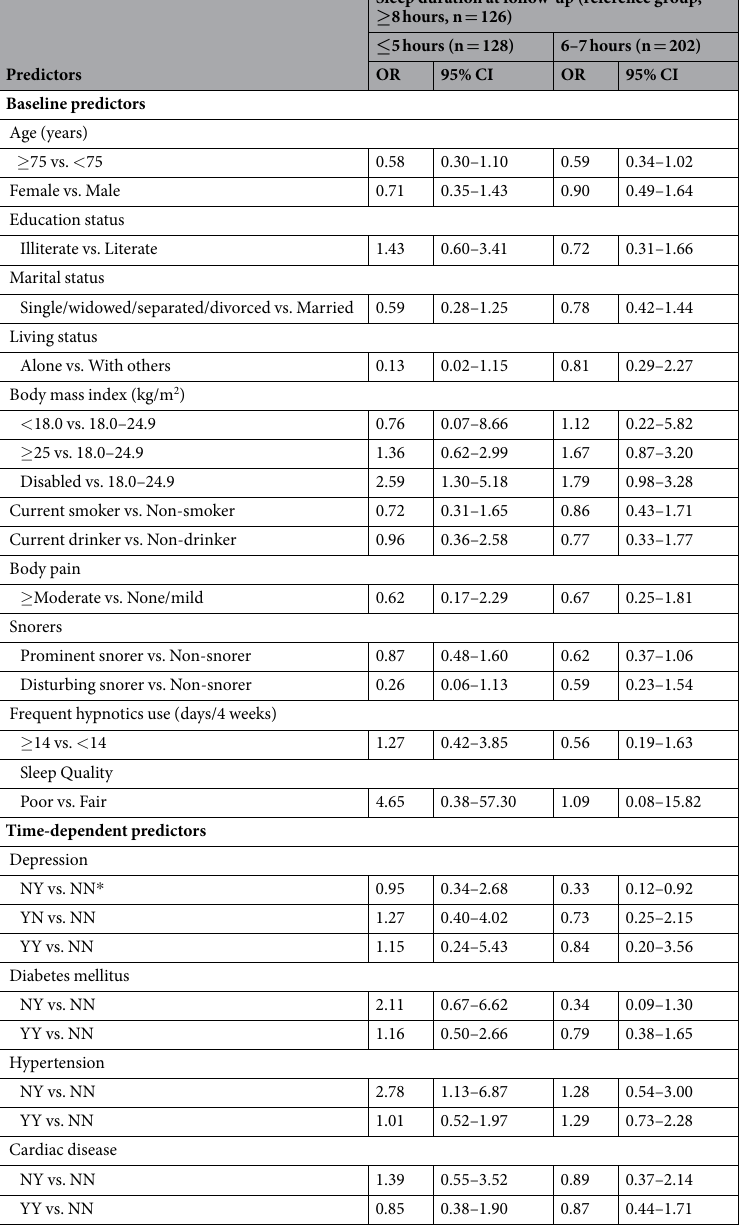
Table 4. Multinomial logistic regression for factors predicting change of sleep duration among long sleepers at baseline (n = 456). * NN: absent for both baseline and follow-up survey; NY: incident condition during the follow-up period; YN: present in the baseline but remitted during follow-up; YY: present in the